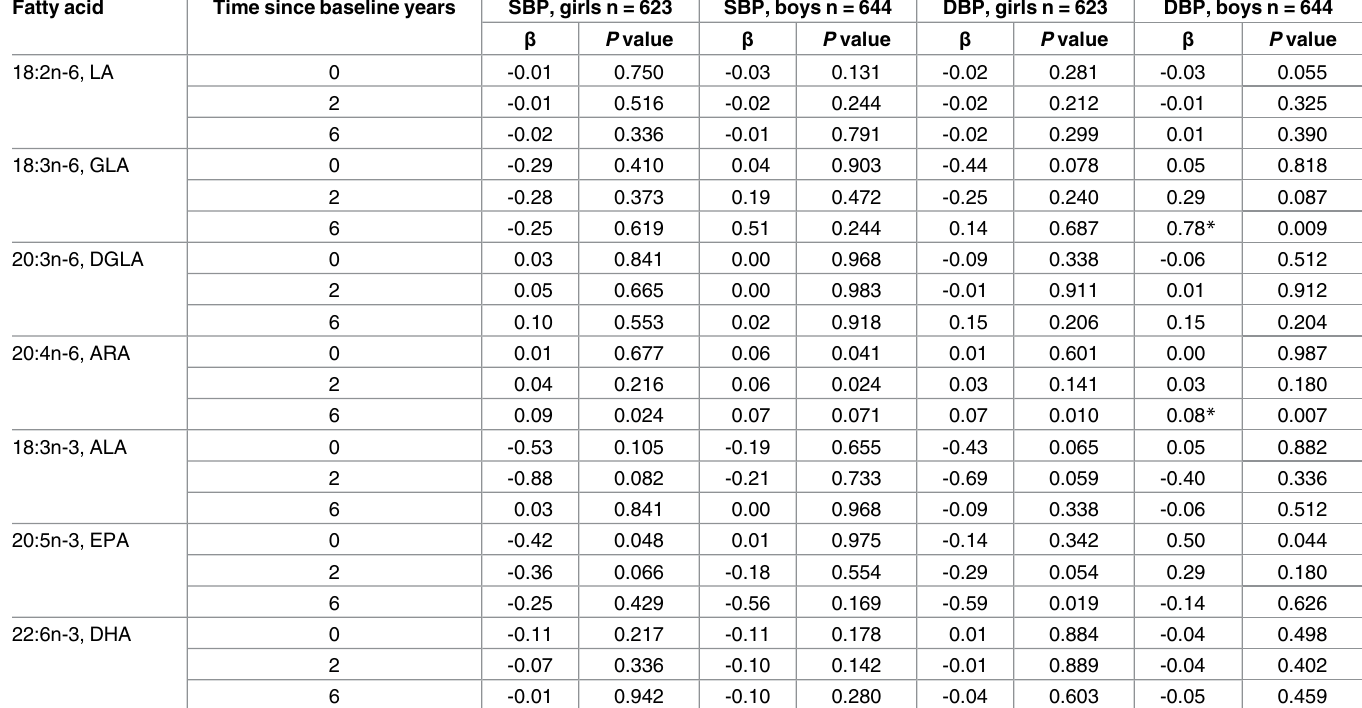
Table 4. Associations of fatty acids with systolic and diastolic blood pressure z-scores at baseline, after two years and after six years of follow- up stratified by sex 1 .